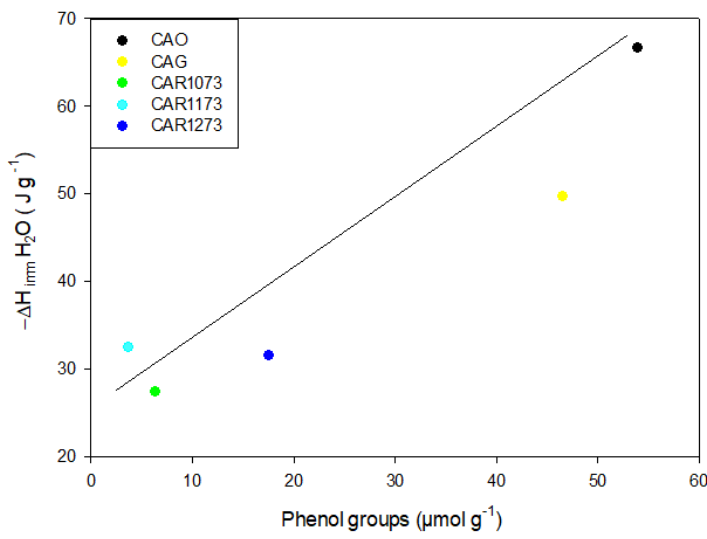
Figure 2. Relationship between the amount of phenol groups and the enthalpy of immersion in water of the activated carbons CAO, CAG, CAR1073, CAR1173, and CAR1273.